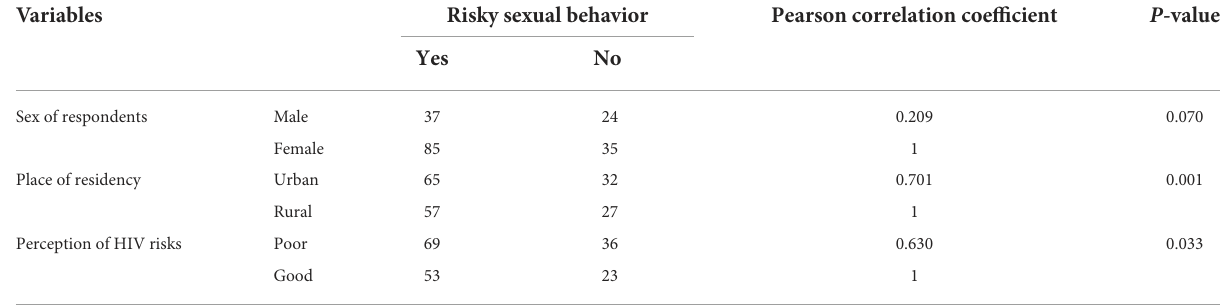
TABLE 5 Correlation test between risky sexual behavior and sociodemographic variables, 2022.